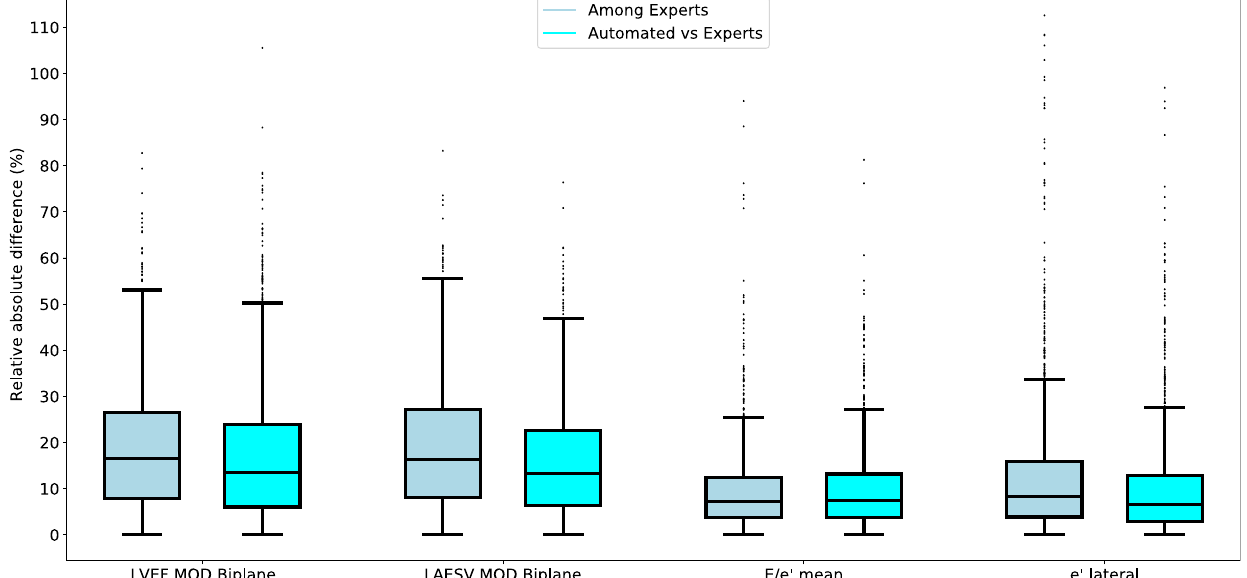
distance between the box ’ bounds and whiskers re fl ect the 25th or 75th percentile plus1.5timestheinterquartilerange(i.e.,thedifferencebetweenthe25thand75th percentile. Abbreviations and N (number of studies): E/e ’ ( N =388); e ’ lateral ( N =458); LAESV, left atrial end systolic volume ( N =507); LVEF, left ventricular ejection fraction ( N